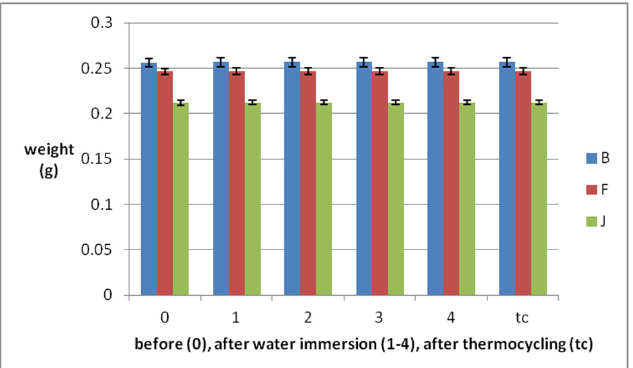
Figure 1. Weight variations of the samples during water immersion periods and thermocycling: average weight values with SD.